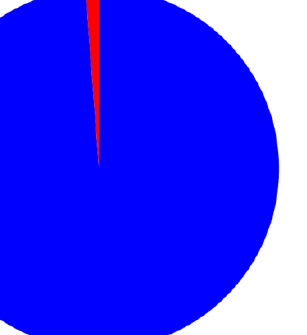
Figure 20. Taxonomy of endophytic fungi isolated from 2002 – 2022.